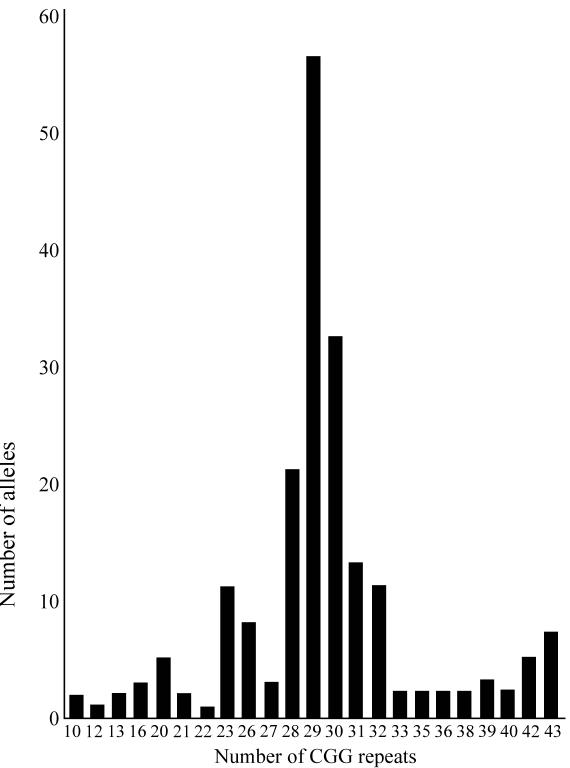
Figure 1 - Distribution of CGG repeats in the non-fragile-X mentally re- tarded population of